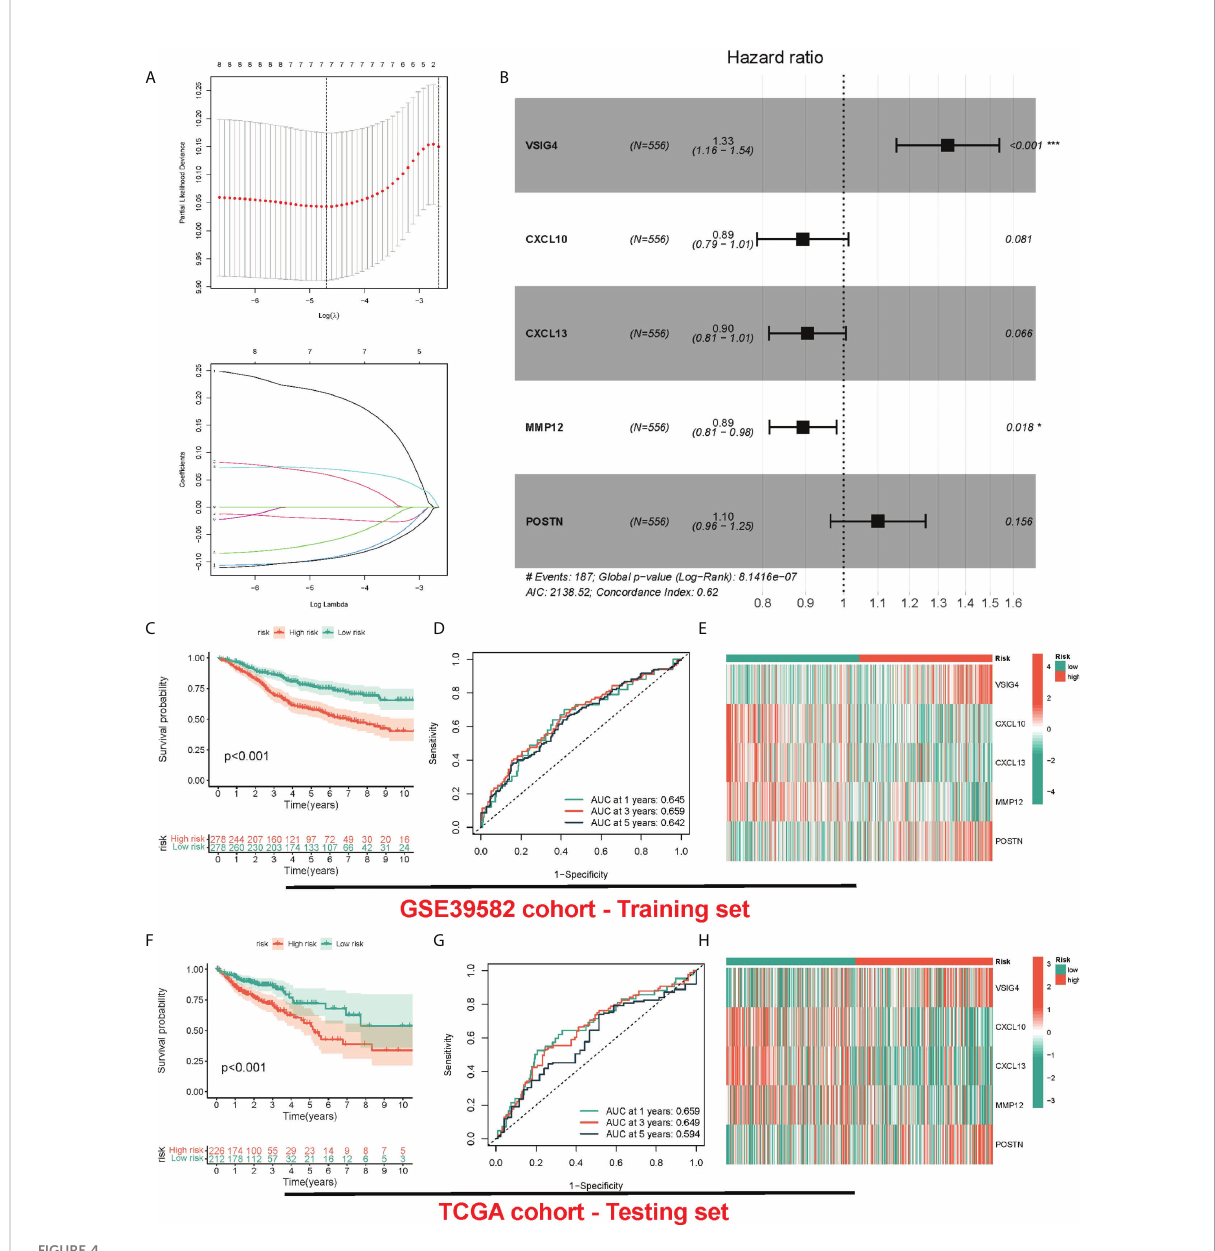
FIGURE 4 Construction and validation of risk model. (A) LASSO Cox regression analysis of PRRs. (B) Forest plot of the fi ve target genes that compose the PRR signature. (C, F) KM survival analysis between low-risk and high-risk groups. (D, G) ROC curves analysis of PRR on OS at 1 year, 3 years, and 5 years. (E, H) Heatmap for the expression of fi ve crucial genes in low-risk and high-risk